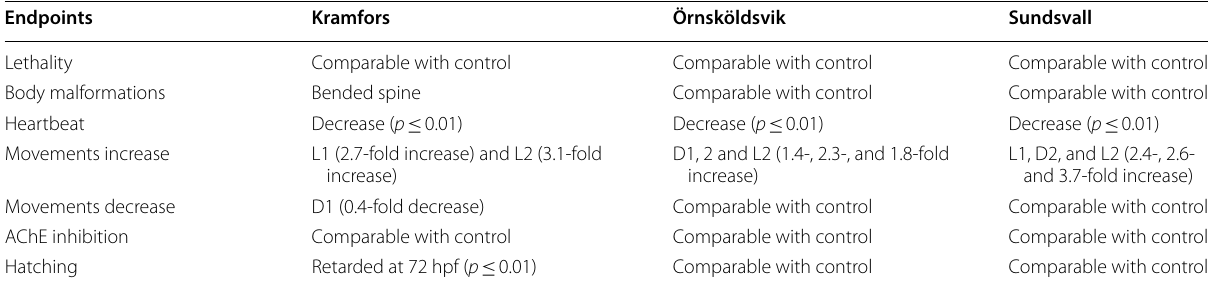
0.001). Centre point show mean and error bars 95% ≤